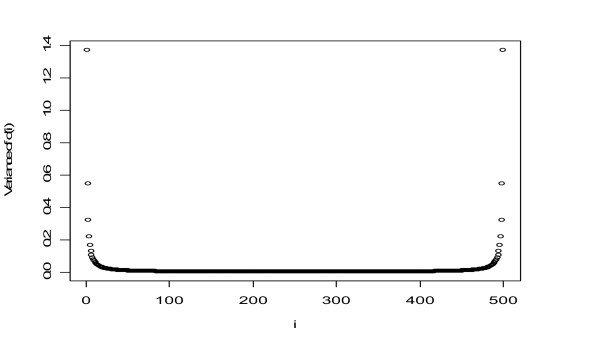
Plot of the variance of the ordered test statistics d(i). The vertical axis displays the values of the variances of the order statistics d(i) for i = 1, ..., 500.